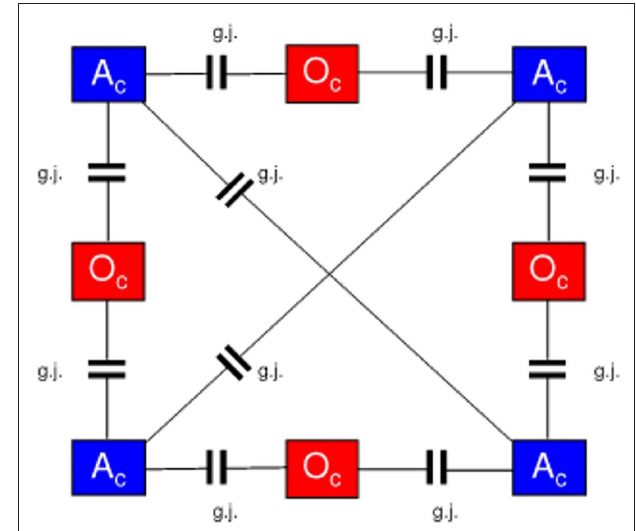
Figure 4 | Outline of a panglial syncytium. Four astrocytes (Ac) and four oligodendrocytes (Oc) are interconnected via gap junctions (g.j.). The network of gap junctions between astrocytes is called astrocytic syncytium. If oligodendrocytes are included, the network forms a panglial